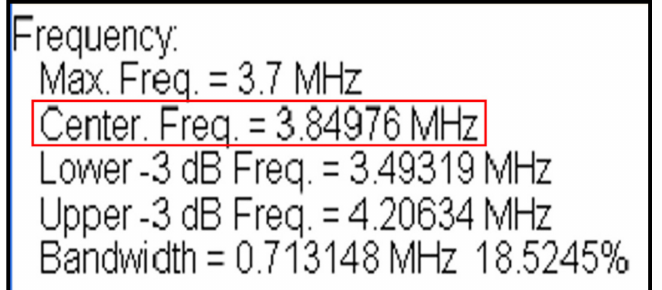
Figure 2. Output